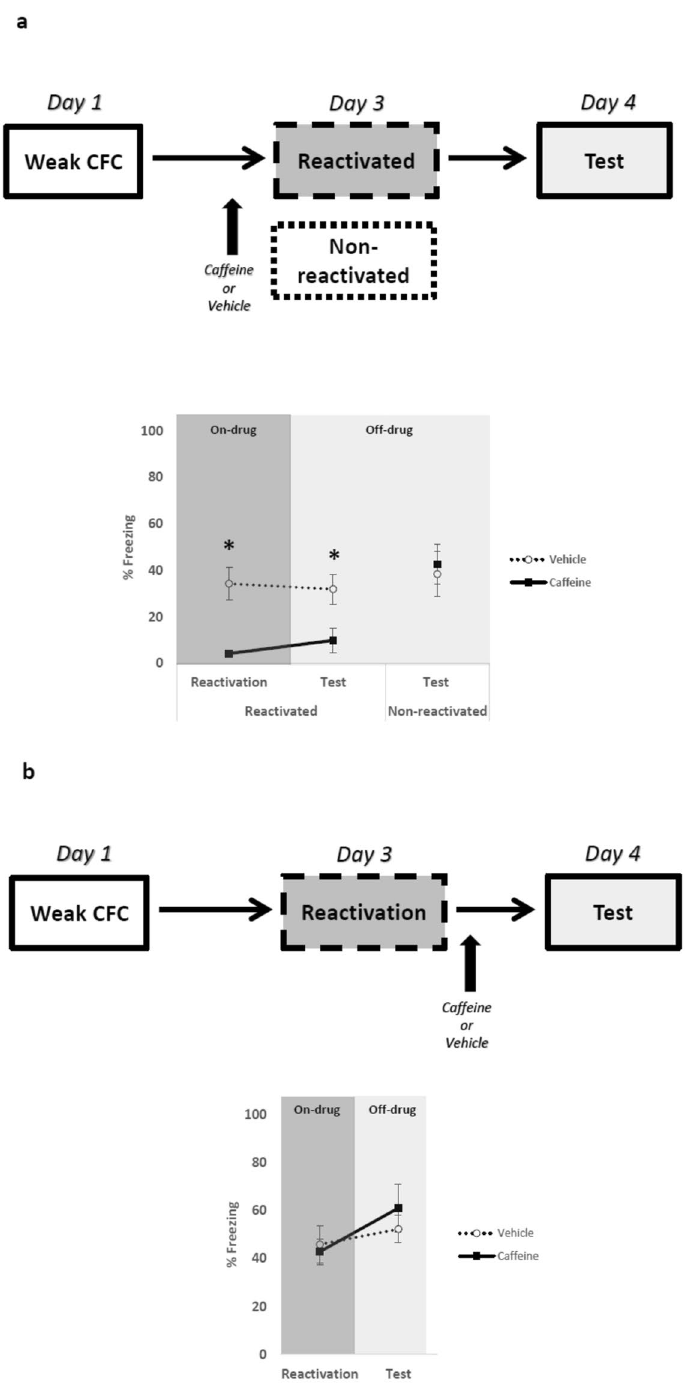
Figure 1. Caffeine administration before but not after single memory reactivation is able to attenuate weak fear memories. The graphs show percent of freezing time expressed as mean ± SEM, and experimental design is shown at the top of each panel; ( a ) Caffeine administration reduces freezing behavior during test with only one memory reactivation after weak training (Vehicle n = 7 and Caffeine n = 6). The same performance was not achieved in non-reactivated animals (Vehicle n = 10 and Caffeine n = 10); ( b ) In addition, there is no effect of caffeine with post-reactivation administration (Vehicle n = 6 and Caffeine n = 7). * p < 0.05, Repeated Measures ANOVA followed by post hoc